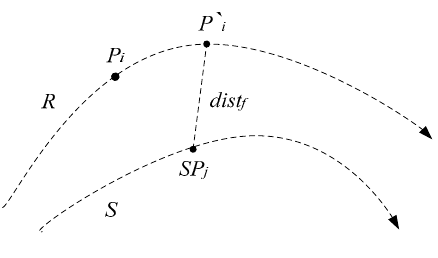
Figure 6. Prediction distance.